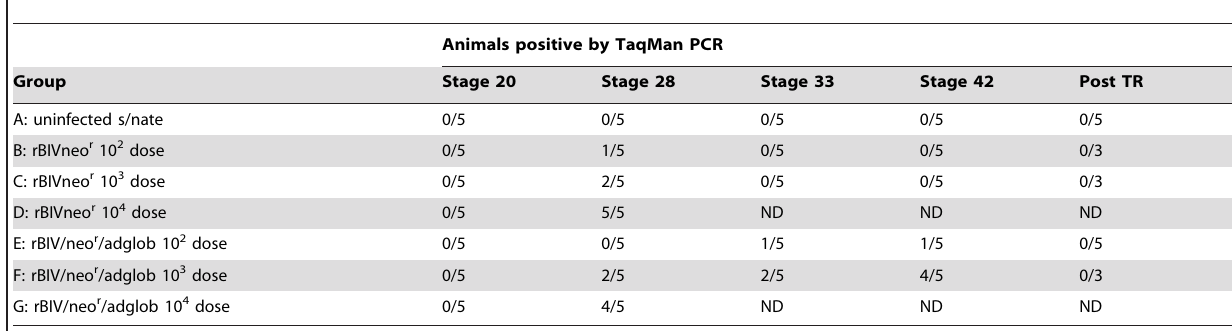
Table 2. Detection of viral DNA in treated and control